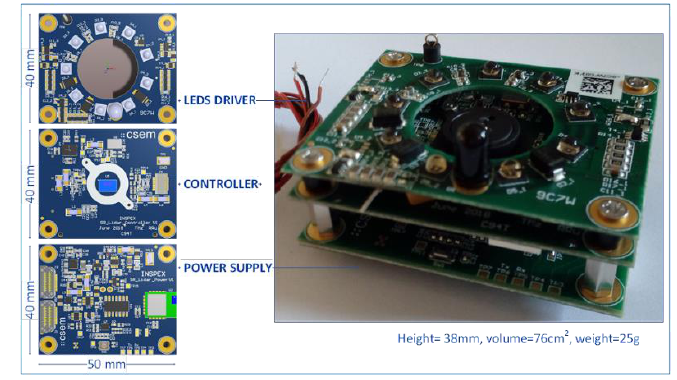
Figure 9. Depth camera (time-of-flight) module.